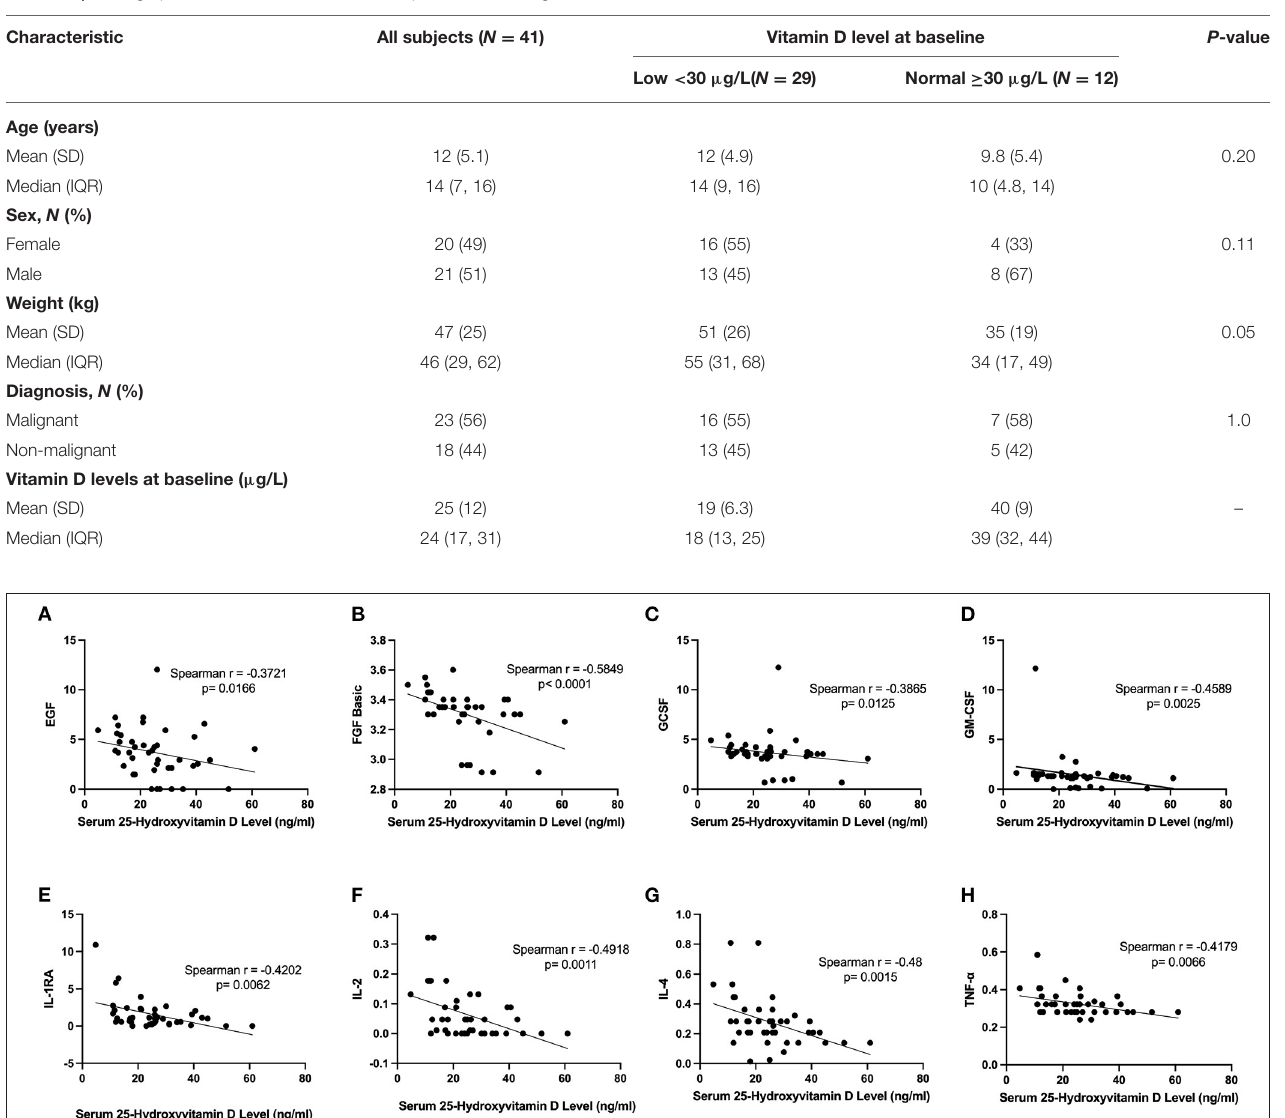
FIGURE 1 | Negative correlation between serum vitamin D levels and inflammatory cytokine profiles. (A) Serum vitamin D levels and serum levels of EGF ( r = − 0.3721, P = 0.0166). (B) Serum vitamin D levels and serum FGF-basic ( r = − 0.5849, P < 0.01). (C) Serum vitamin D levels and serum GCSF ( r = − 0.3865, P = 0.0125). (D) Serum vitamin D levels and serum levels of GMCSF ( r = − 0.4589, P < 0.01). (E) Serum vitamin D levels and serum IL-1RA ( r = − 0.4202, P < 0.01). (F) Serum vitamin D levels and serum IL-2 ( r = − 0.4918, P < 0.01). (G) Serum vitamin D levels and serum levels of IL-4 ( r = − 0.48, P < 0.01). (H) Serum vitamin